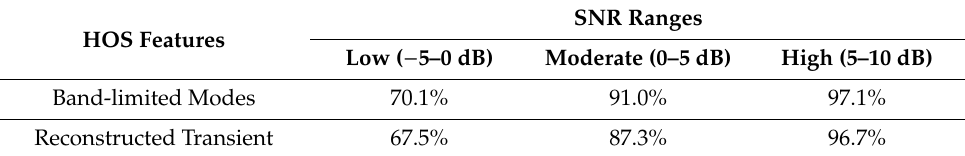
Table 2. The overall classification accuracies under di ff erent SNR